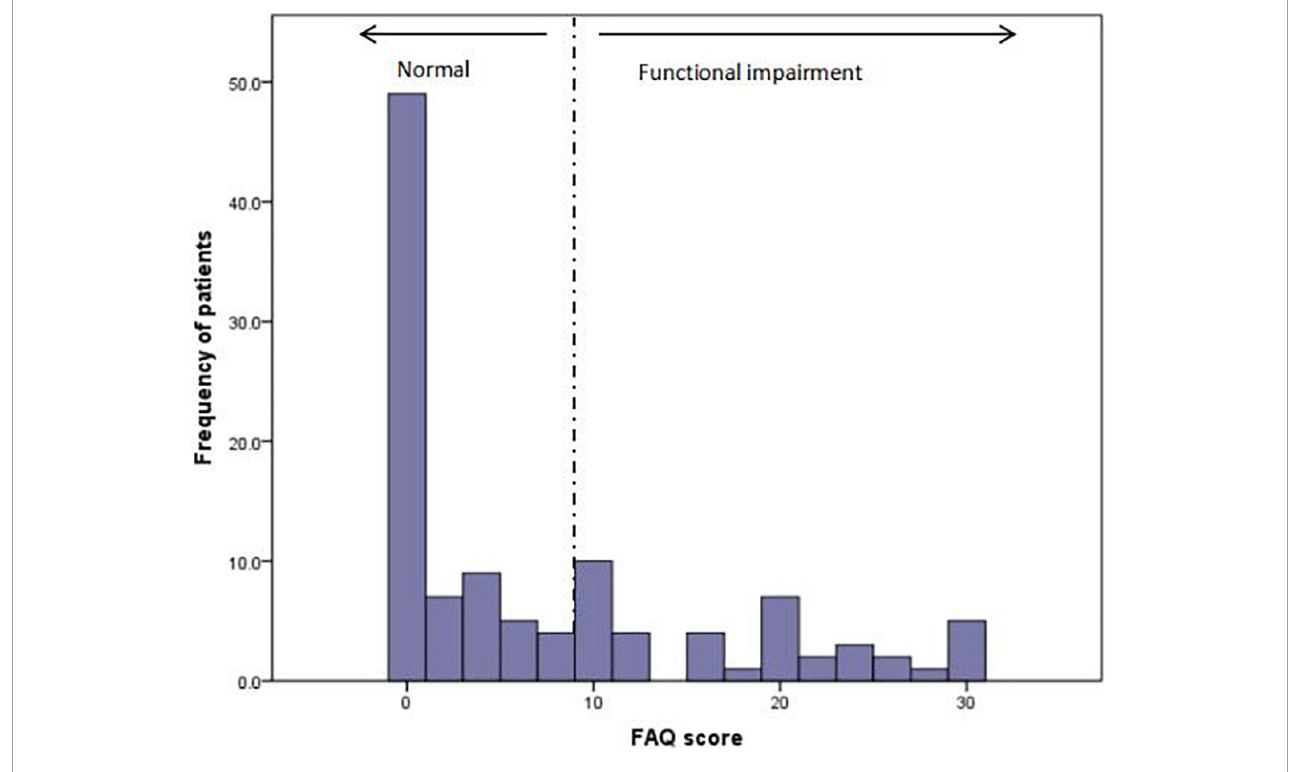
FIGURE1 Distribution of functional